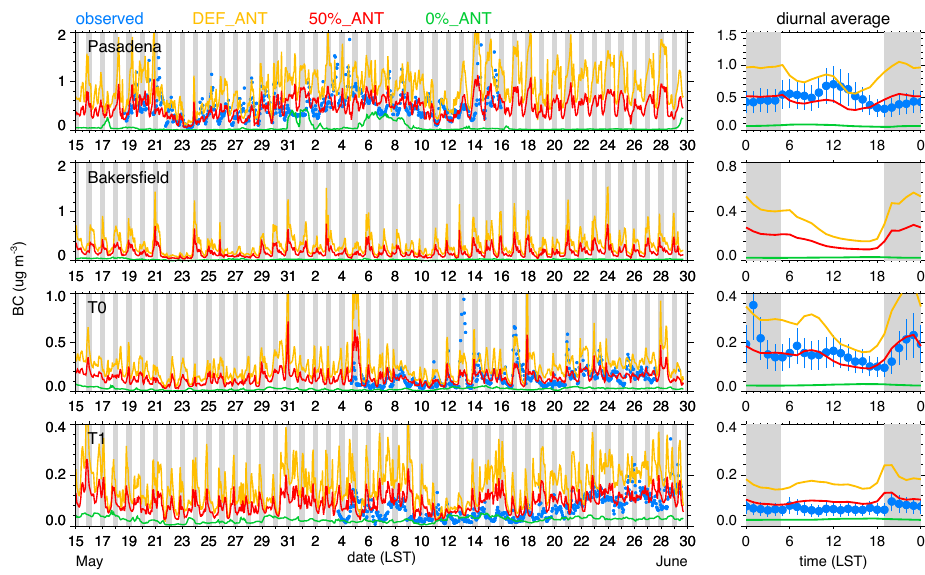
Figure 8. Observed and simulated time series (left panels) and average diurnal variation (right panels) of BC at the four supersites. Simulated BC is the total of the first four model size bins (i.e., aerosol diameters up to 0.625µm). Gray shading denotes night and vertical lines in right panels denote measurement uncertainty range. Results from 50%_LBC simulation not shown since it is nearly the same as the 50%_ANT simulation. Bakersfield results shown for completeness even though no BC measurements were made at that site.